Question: Provide a one-line summary of what is displayed.
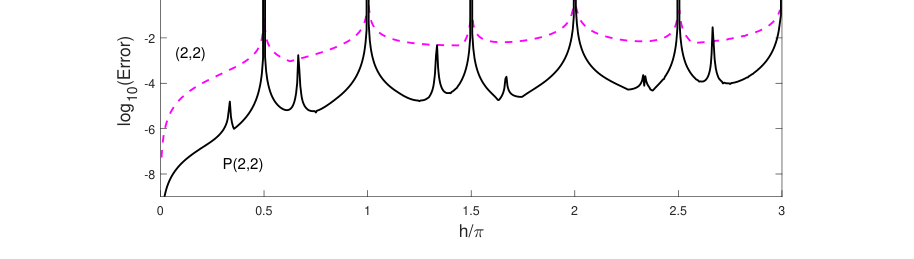
Answer: 1. Pendulum. Evolution of relative errors in energy (left) and in phase space (right) obtained with St¨ormer–Verlet, 𝑆2, scheme 𝑆[𝑅𝐾𝑅] ℎ , denoted (2,2), and the processed (2,2), P(2, 2) with initial state (𝑞0, 𝑝0) = (1/10, 0) and step size ℎ= 5/6.